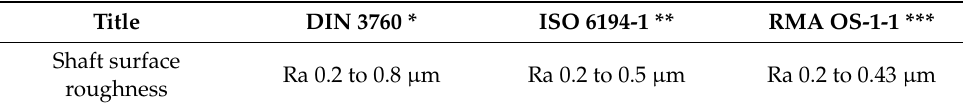
Table 6. Specifications for Radial Lip Seals Mating Surfaces (Sleeve) according to ISO, DIN & RMA Standards.